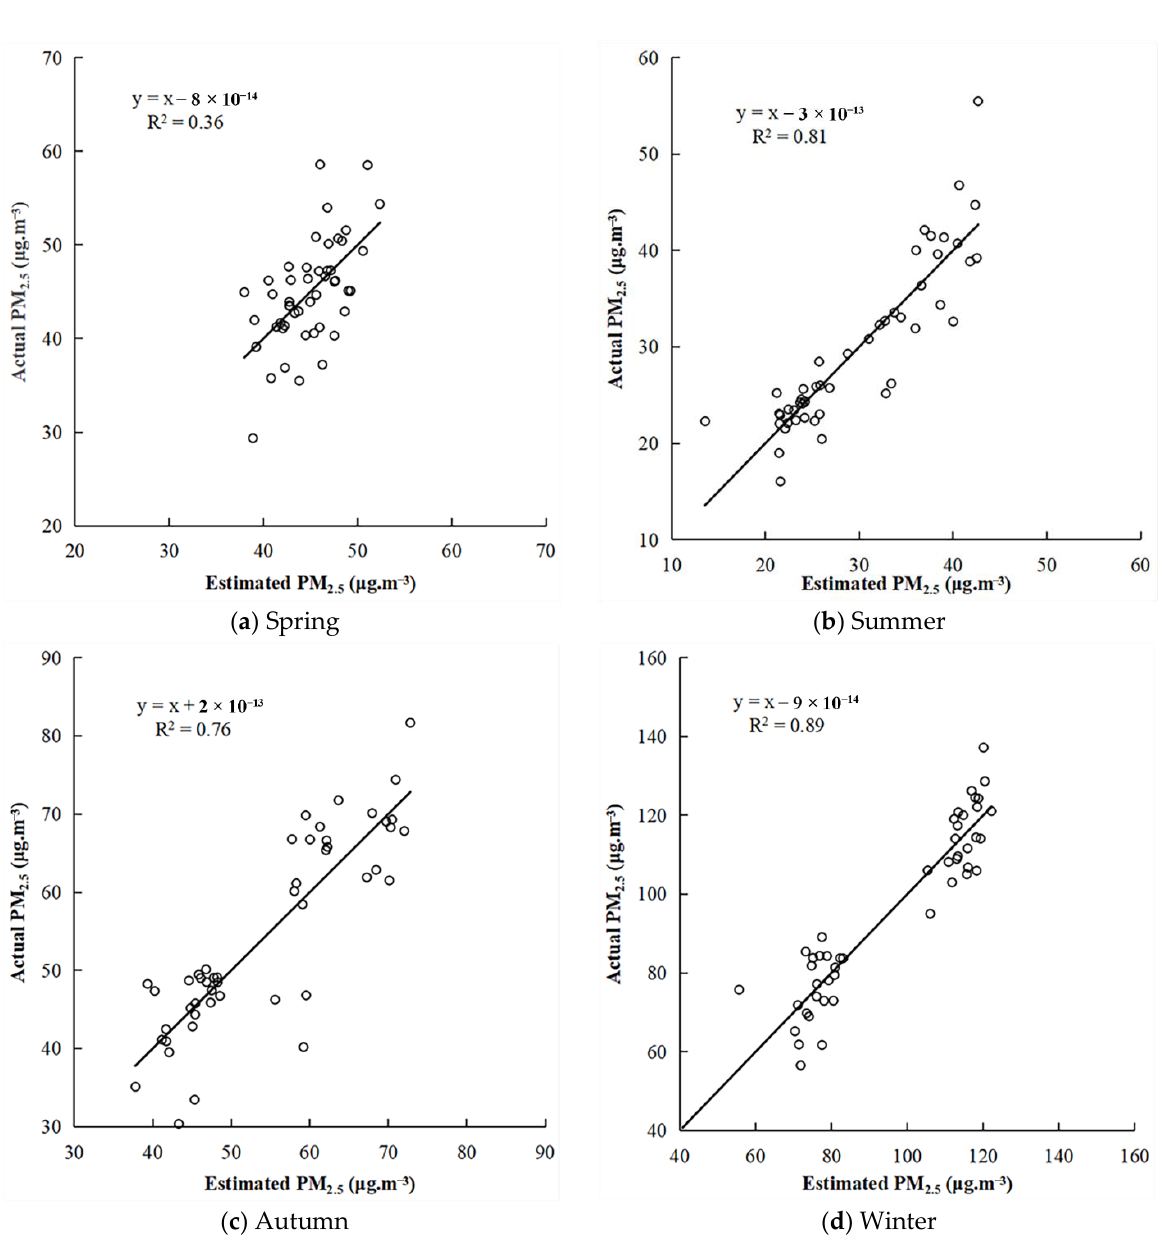
2.5 concentrations in the four